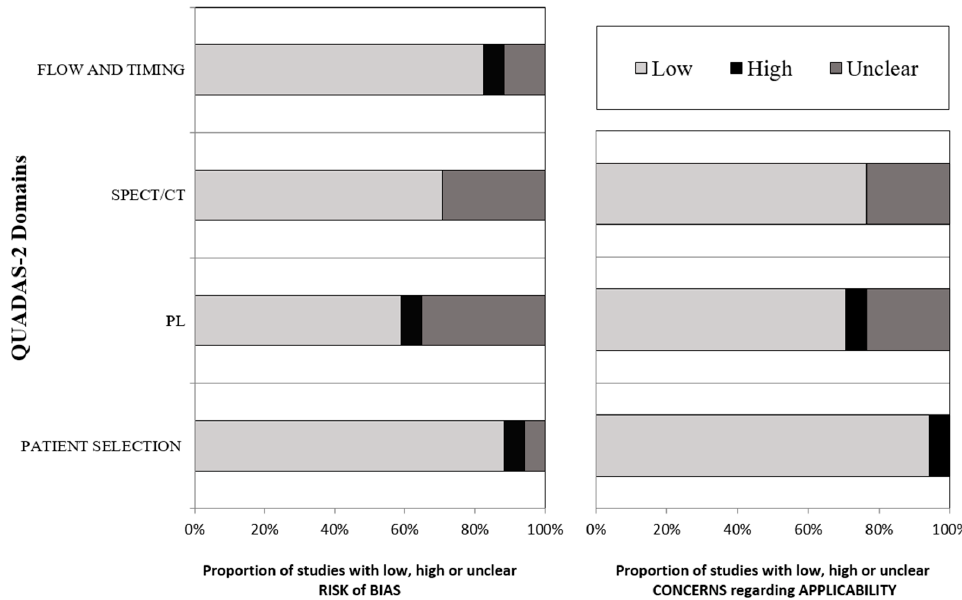
Figure 2. Version 2 of the “Quality Assessment of Diagnostic Accuracy Studies” tool (QUADAS-2) results.